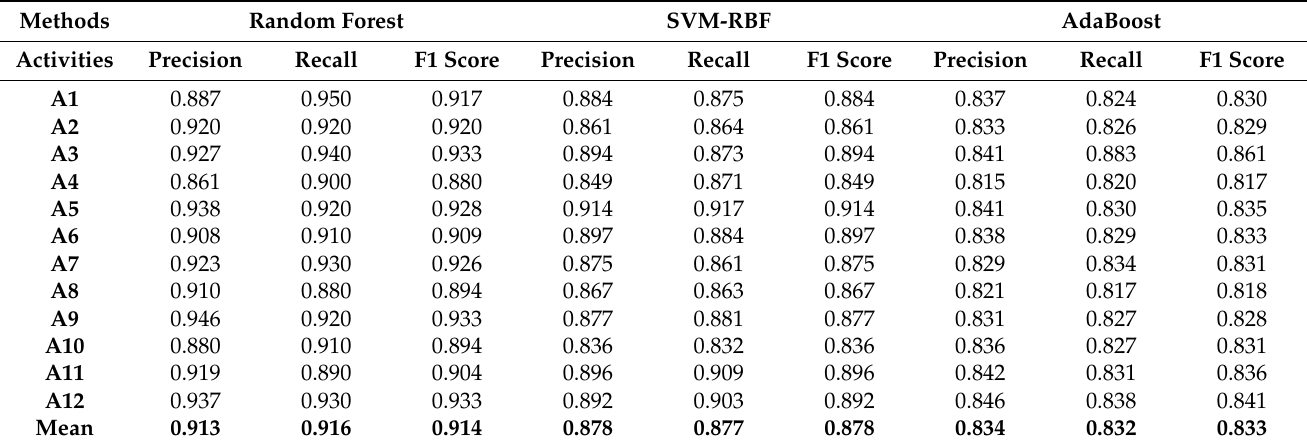
Table 3. Comparison of the evaluation metrics (precision, recall, and F1 score) of the HPAR model from the PAMAP-2 dataset.